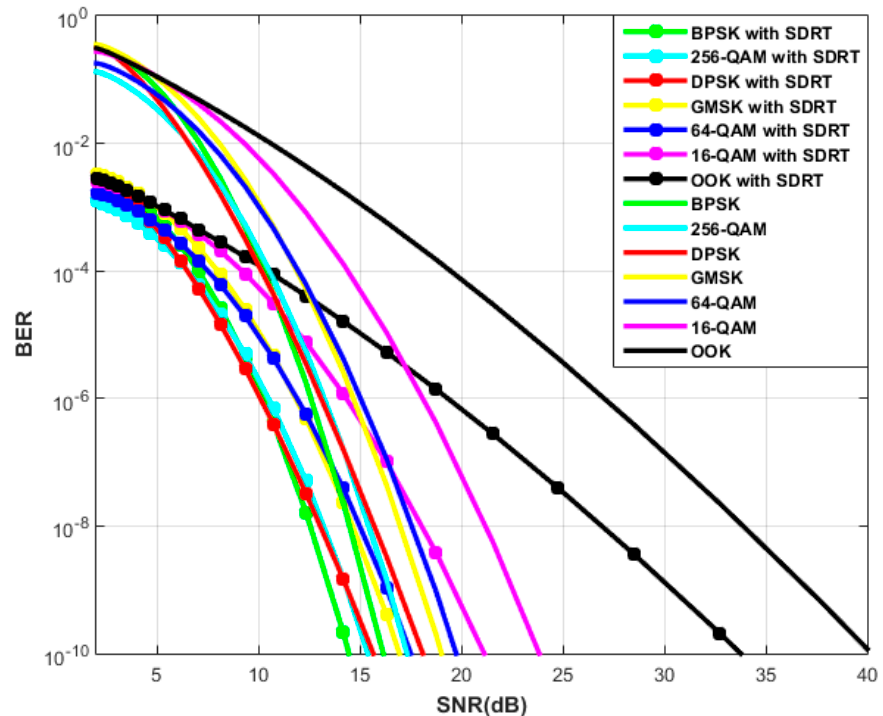
Figure 8. BER performance of di ff erent modulation formats with SDRT and without SDRT in a moderate turbulence